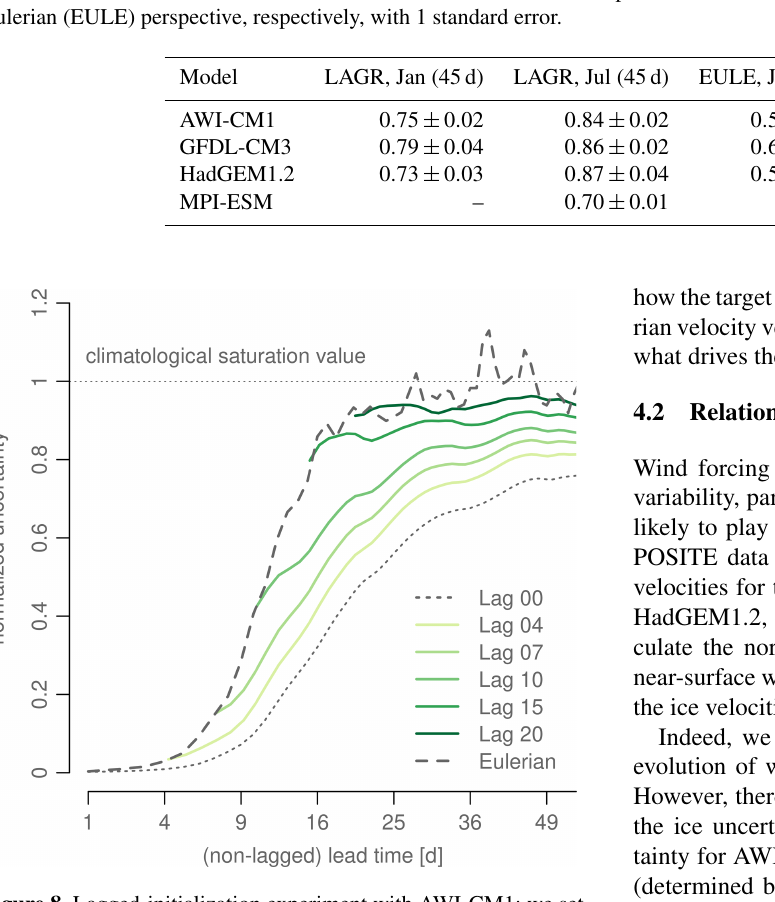
Figure 8. Lagged-initialization experiment with AWI-CM1: we set virtual buoys at the same initial positions as before but delay the release by 4, 7, 10, 15, and 20d. The colored lines show the nor- malized uncertainty on the non-lagged time axis. The dashed lines show the uncertainty for the Eulerian perspective and the dotted line the uncertainty in non-lagged Lagrangian trajectories (“Lag 00”). The initial uncertainty in the lagged Lagrangian trajectories matches closely the uncertainty in the Eulerian perspective at the respective time of buoy